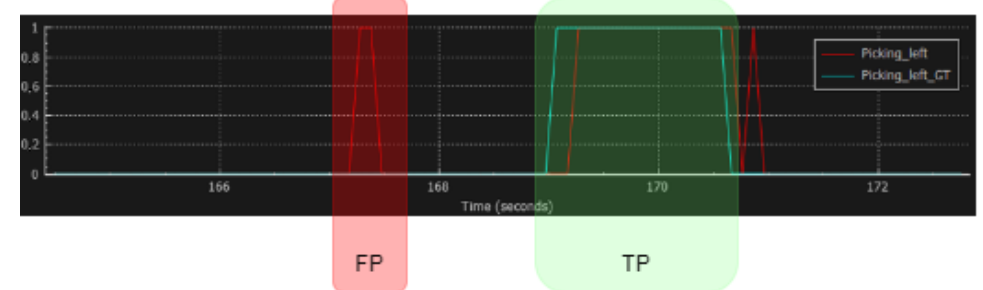
Figure 9. An example of an implemented CoppeliaSimEdu Graph element.